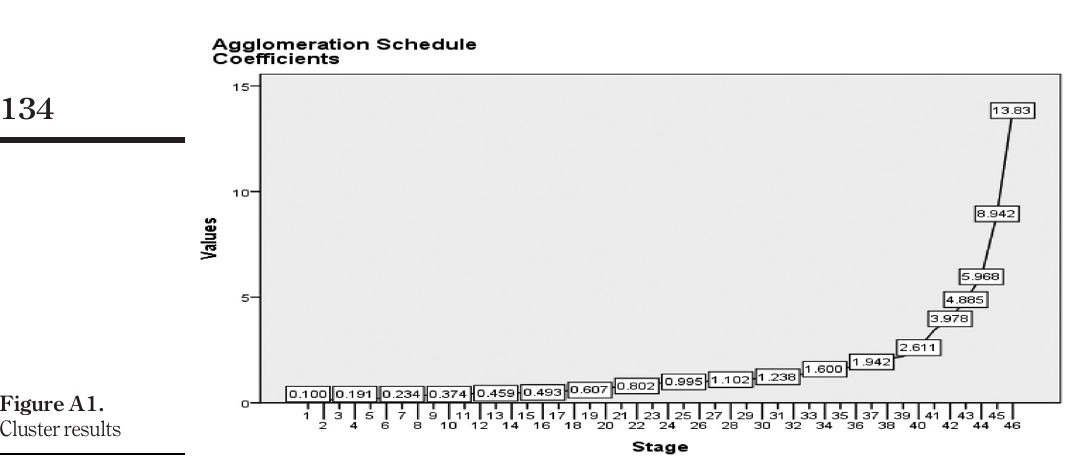
Figure A1. Cluster